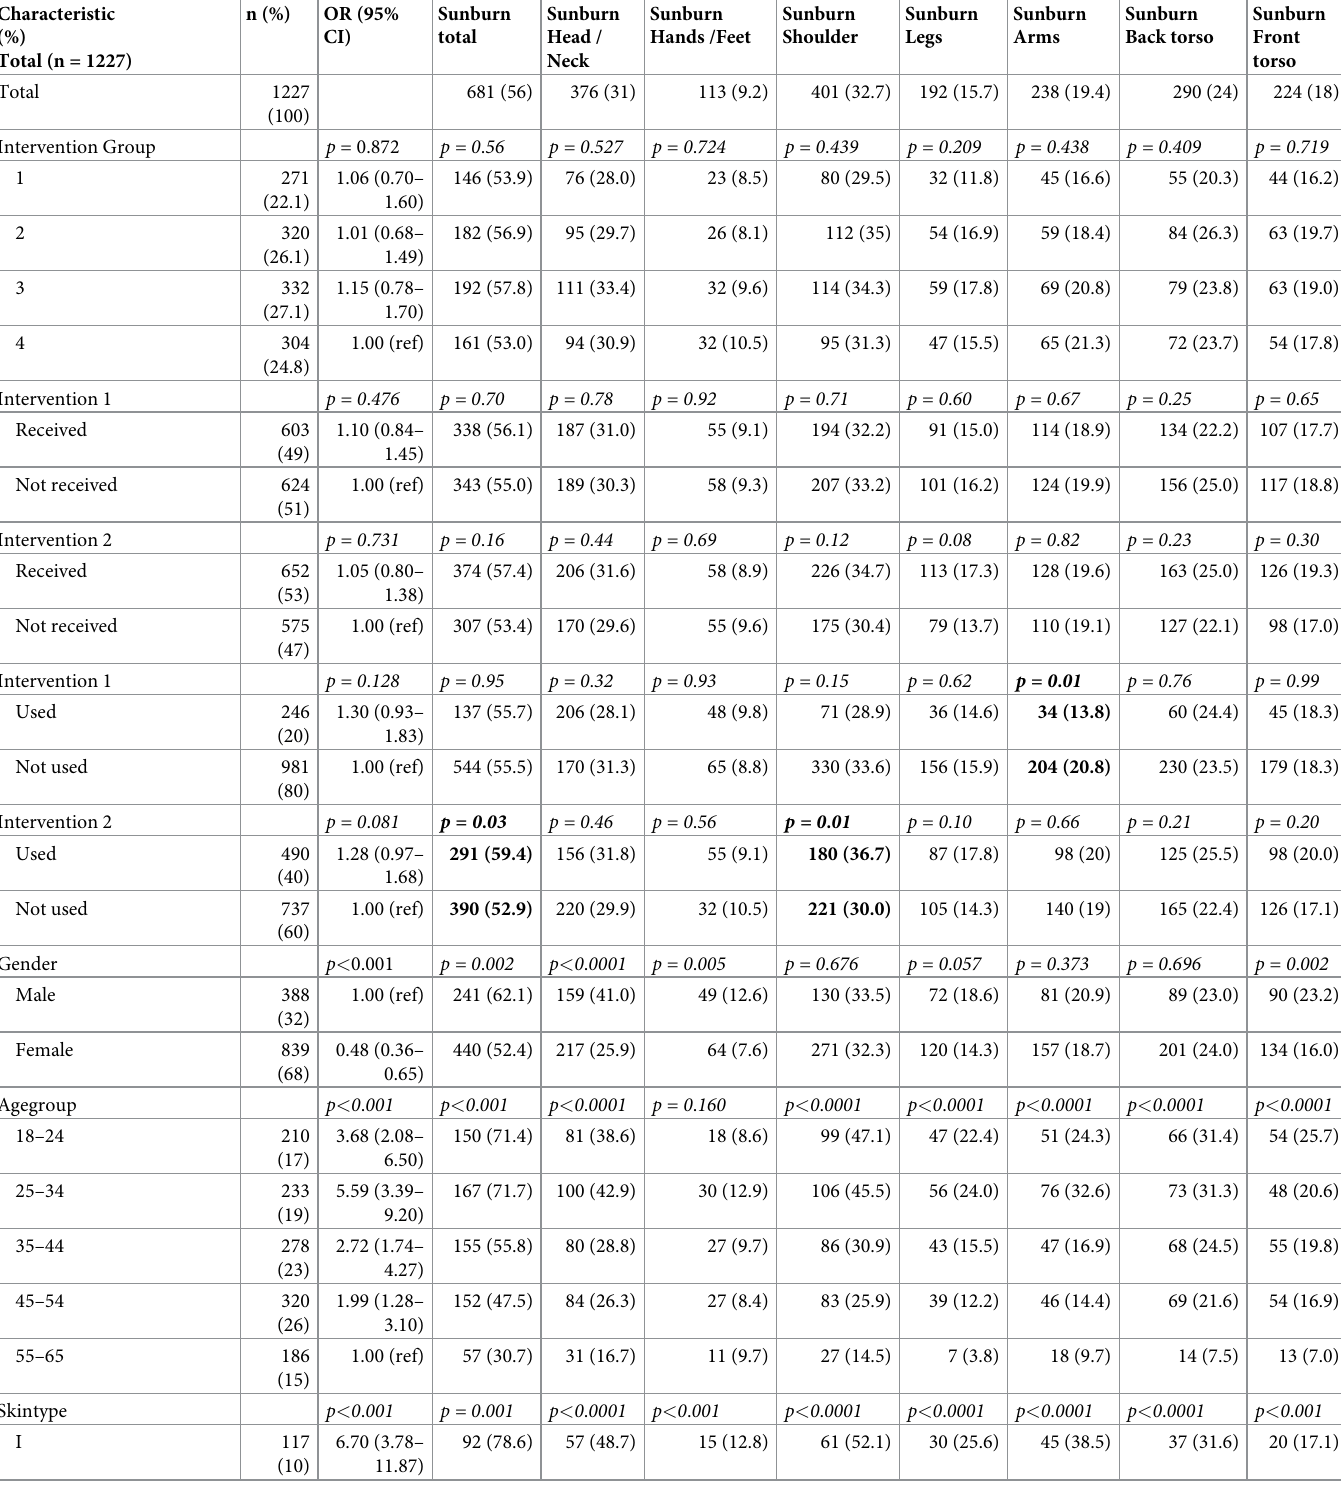
Table 3. Logistic regression analysis of dichotomous sunburn by intervention/Intervention usage (left). Distribution of total sunburn and sunburn specific site on demographic variables and intervention groups (right). Characteristic